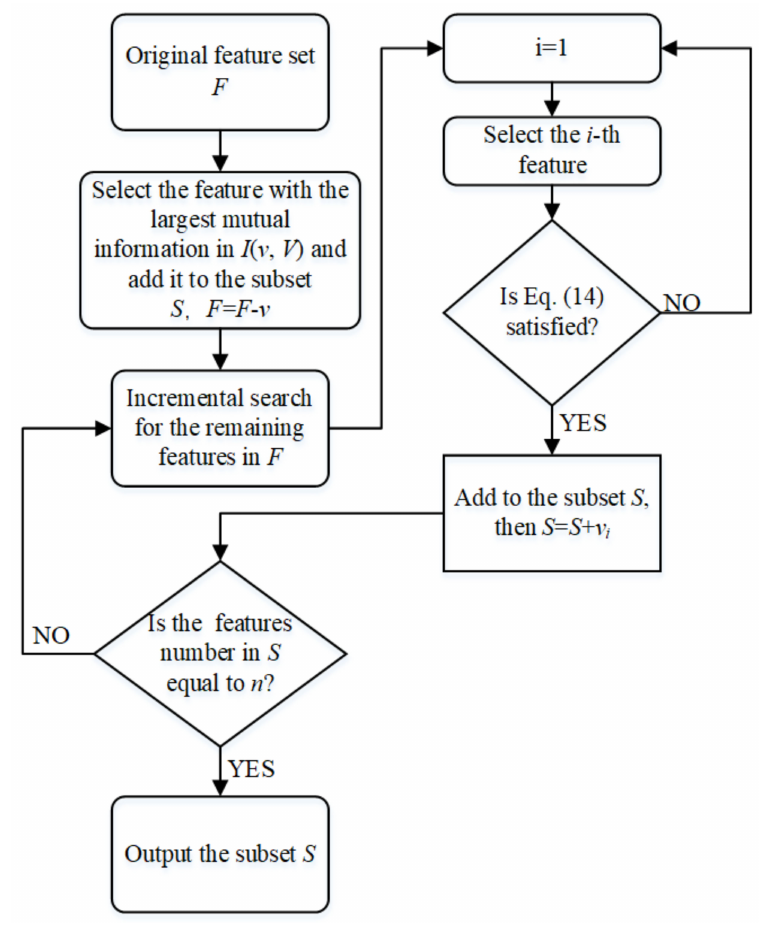
Figure 3. Flow chart for the representative power plant selection